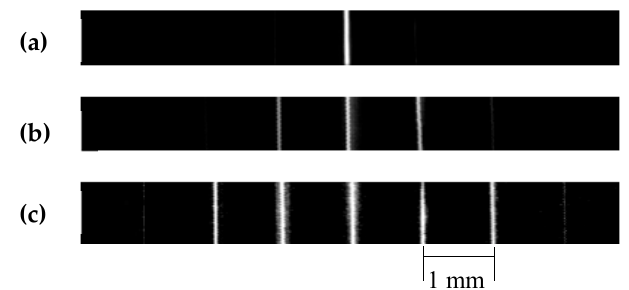
Figure 10. C-scan images of the wire phantom of ( a ) single-focal point transducer T 1 , ( b ) multifocal point transducer with three focal points T 2 , and ( c ) multifocal point transducer with five focal points T 3 .